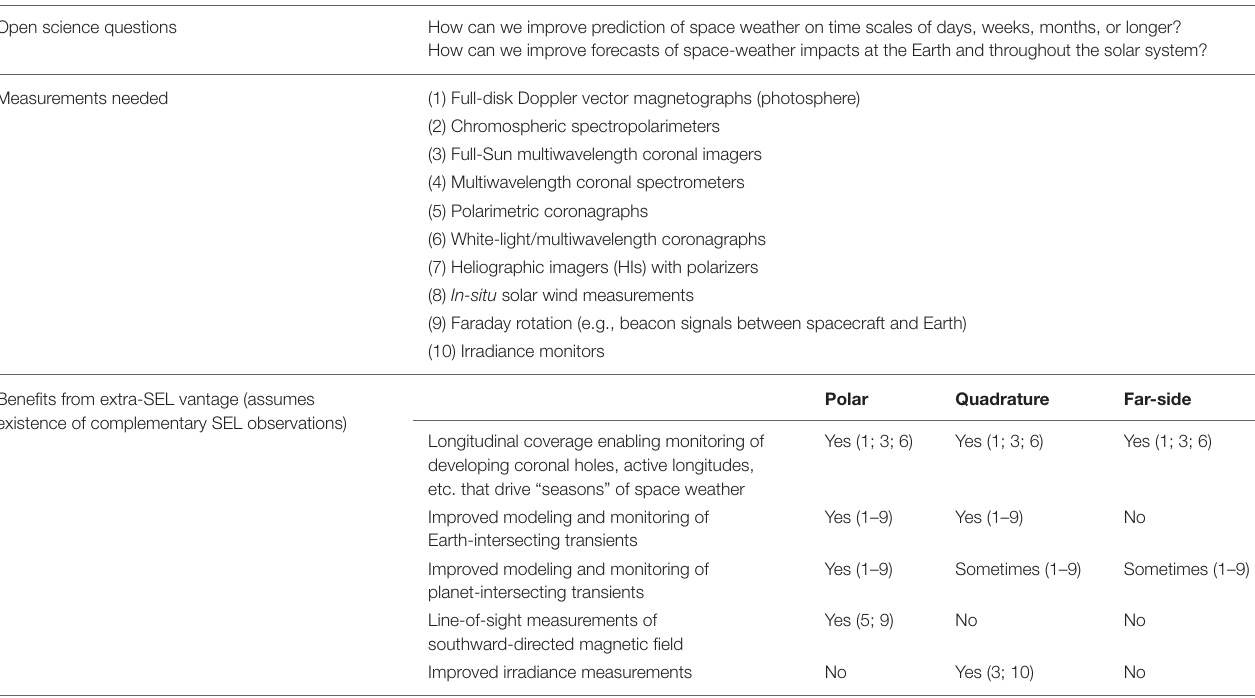
TABLE 4 | Space-weather prediction and modeling enabled by extra-SEL observations. Open science